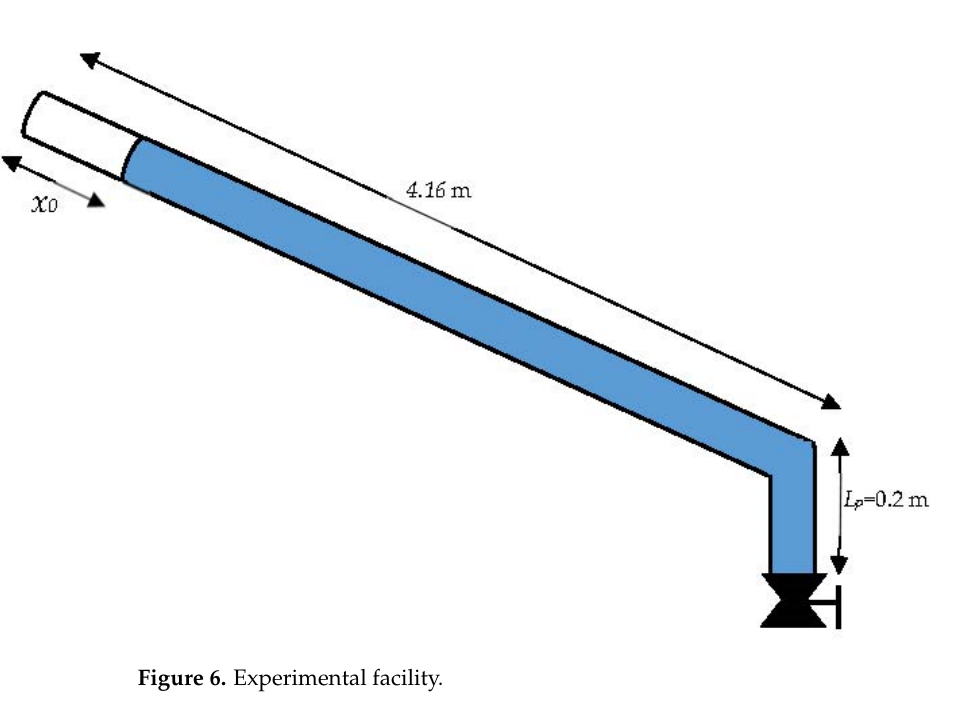
8 of 15 Table 1. Newton–Raphson method . i